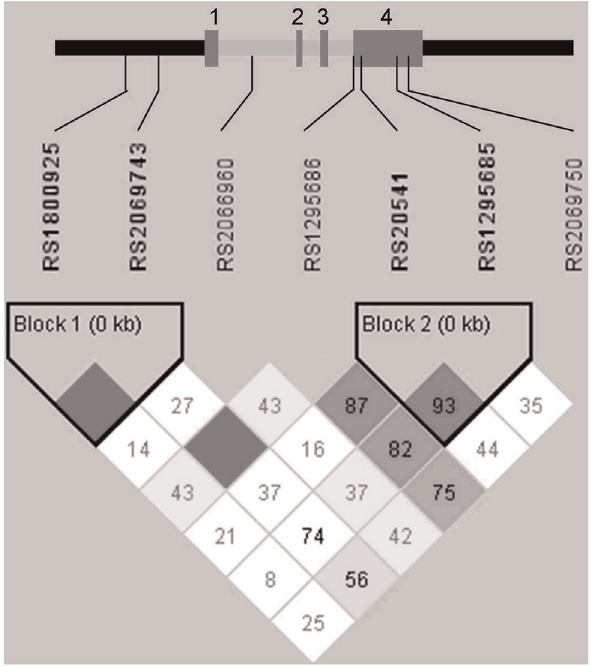
Figure 1. Pairwise linkage disequilibrium (LD) within Haplo- view using the D’ statistic for IL13 . Intensity of shading indicates the degree of confidence in the D’ value. Dark filled squares indicate a D’ value of 1. Untranslated regions are indicated with black bars, exons with dark gray bars and introns with light gray bars. Exons are numbered from 5 9 to 3 9 .